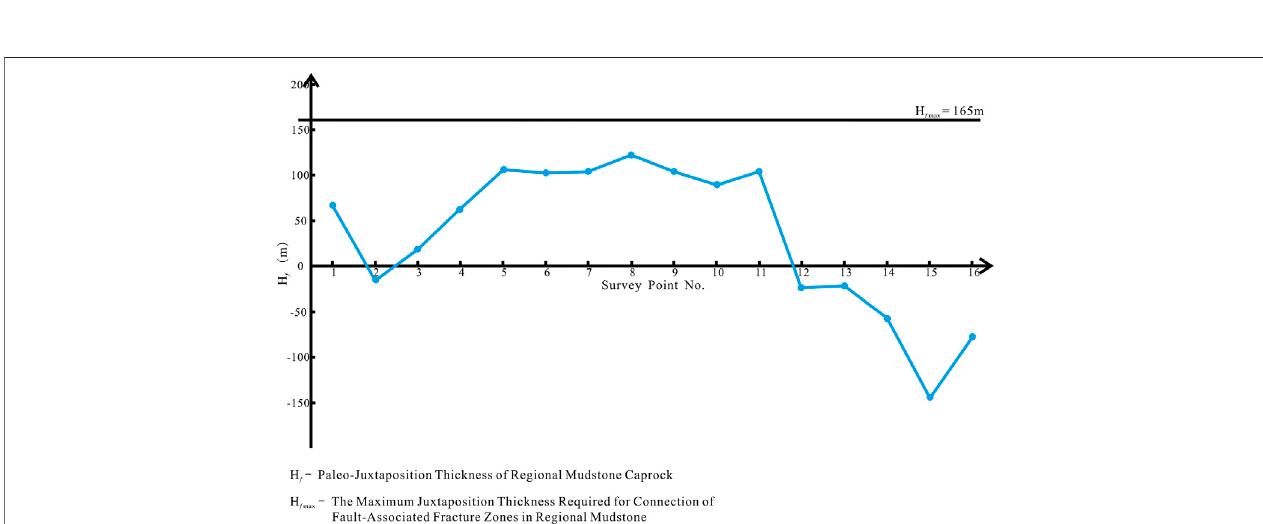
Frontiers in Earth Science |